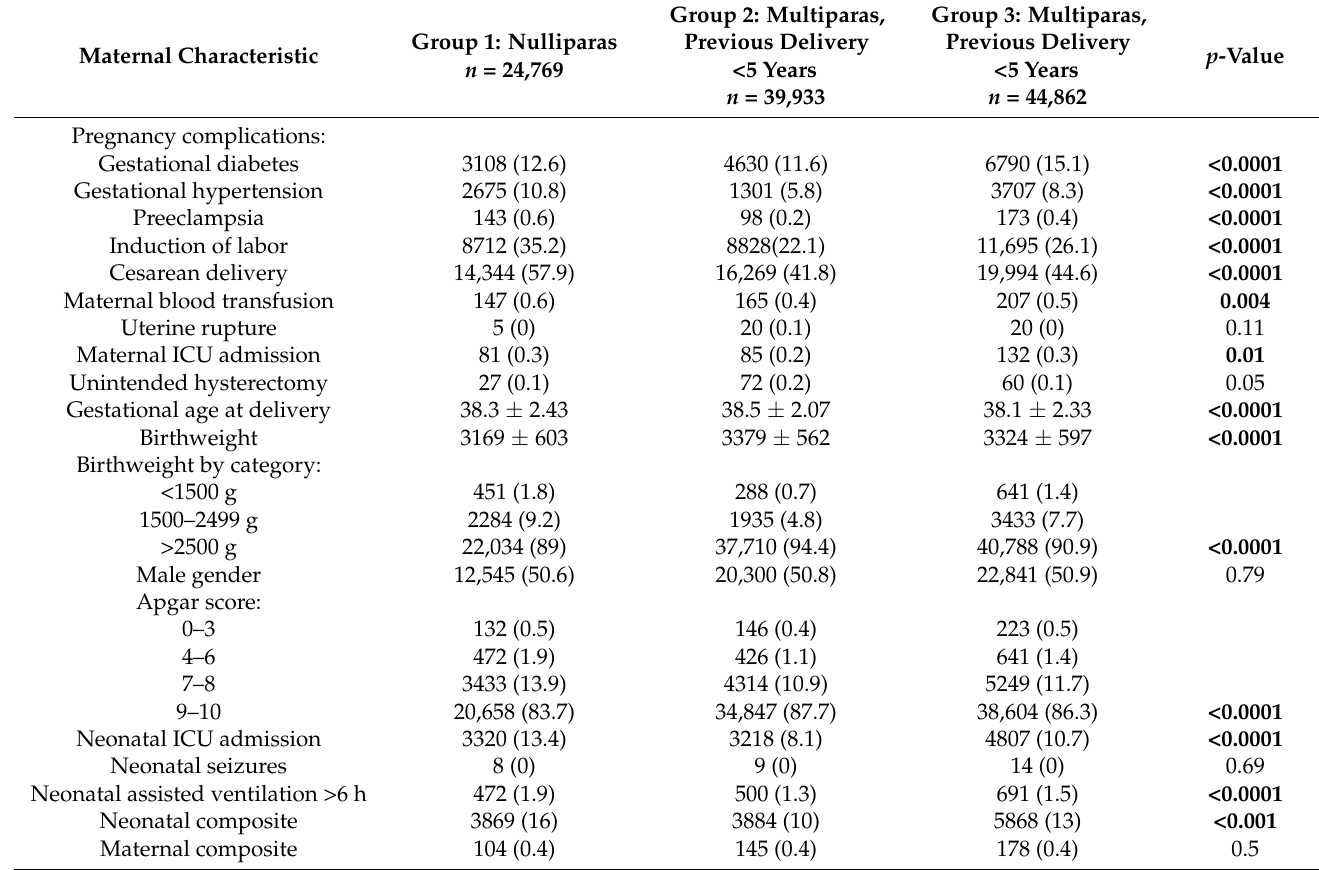
Table 2. Perinatal outcome stratified by parity and interval from previous delivery.